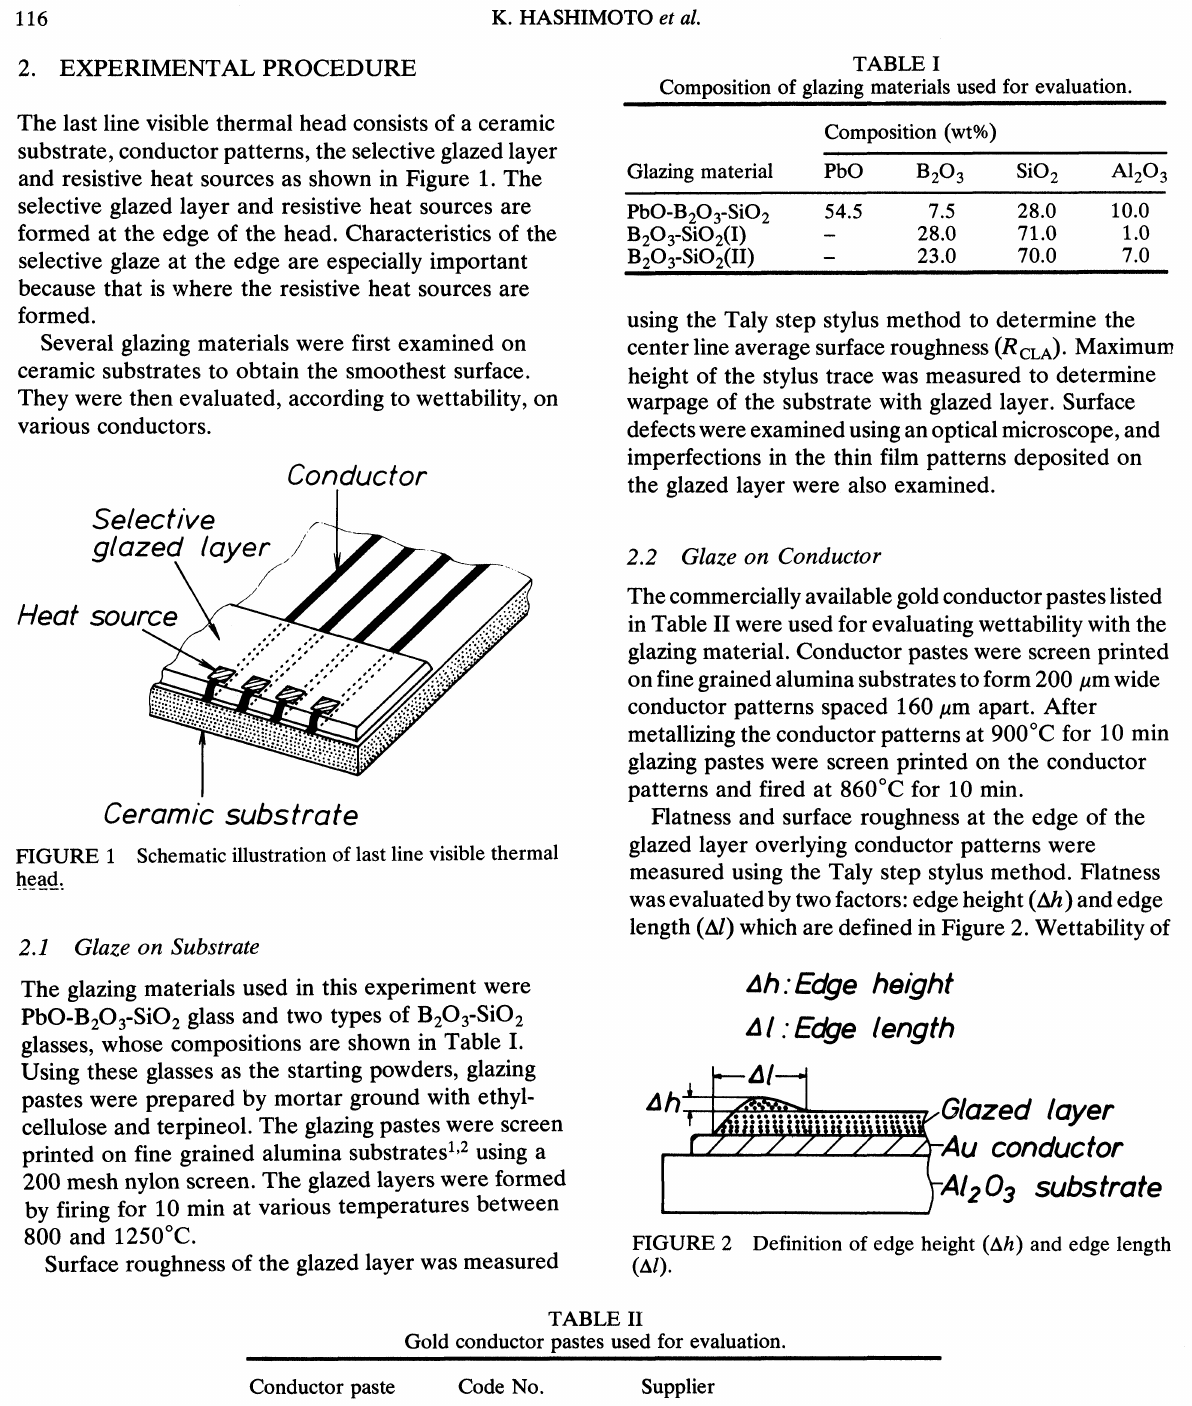
TABLE II Gold conductor pastes used for